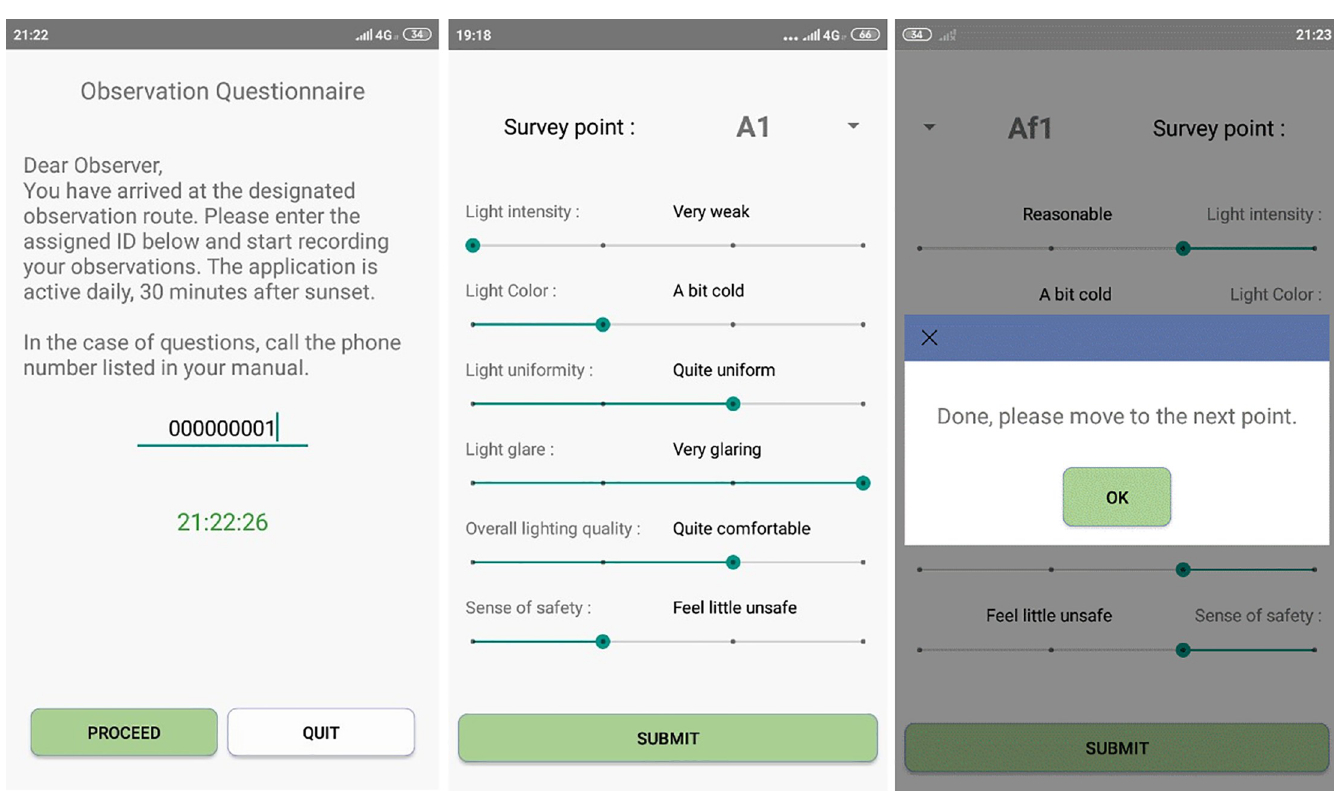
Fig 1. Screenshots of the CityLights TM mobile application used to collect PSL and FoS assessments. A–entry screen; B–survey questions screen; C–direction screen.